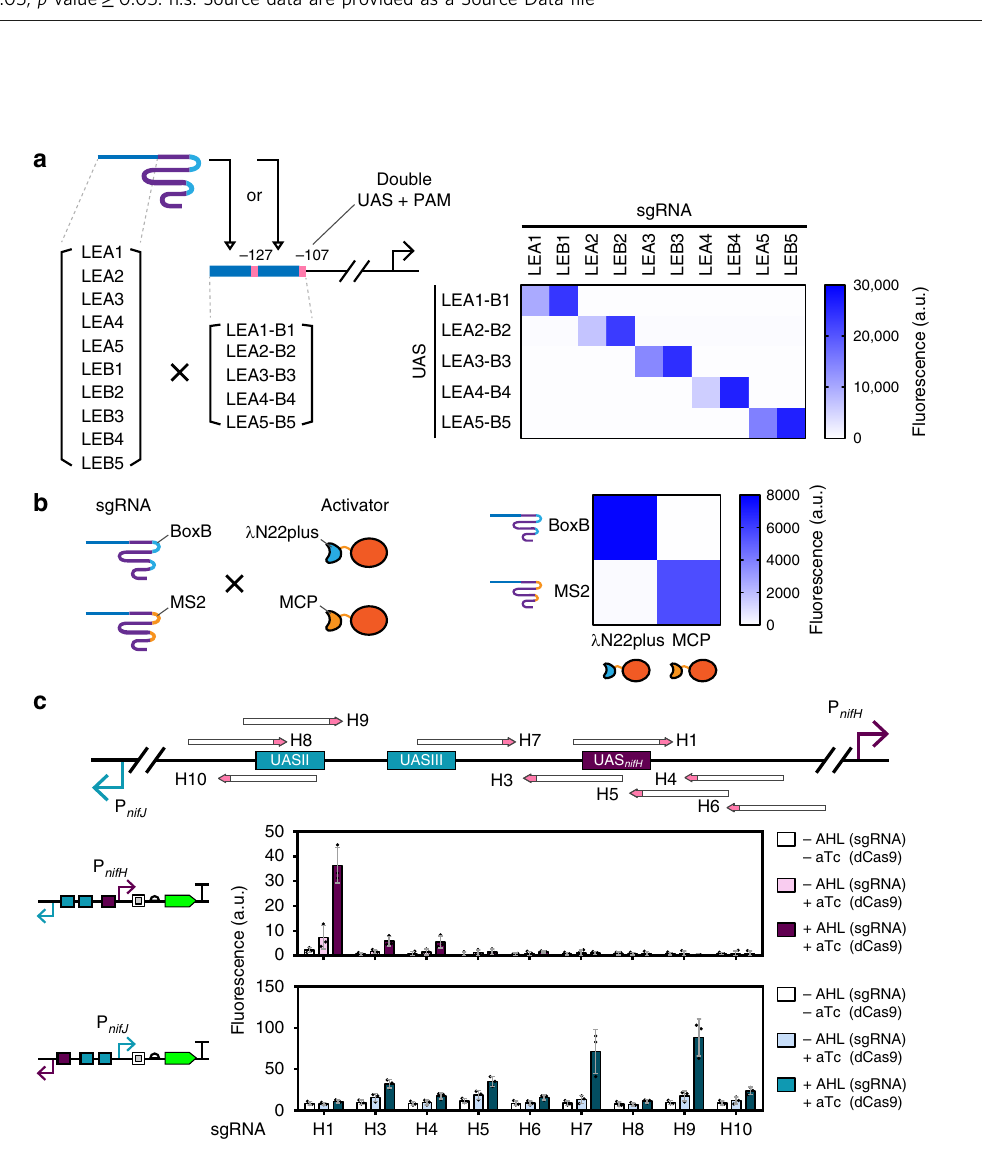
Fig. 3 Functional expansion with different σ 54 -dependent promoters and bEBPs. a Activation of P pspA , P hrpL , P nifH , P nifJ in E. coli . Inducer concentrations used: For P pspA and P hrpL activation, 1.6 µ M AHL (sgRNA), 2.5 ng mL − 1 aTc (dCas9), 0.4 m M rhamnose (activator). For P nifH and P nifJ activation, 1.6 µ M AHL (sgRNA), 2.5 ng mL − 1 aTc (dCas9), 3.2 m M rhamnose (activator). Statistical difference was determined by a two-tailed Welch ’ s t test: P pspA , p = 0.0011, t = 30.69; P hrpL , p = 0.0006, t = 38.34; P nifH (H1), p = 0.0134, t = 8.093; P nifJ (H7), p = 0.0536, t = 4.053; P nifJ (H9), p = 0.0242, t = 6.137. The data of P nifH and P nifJ are identical to those shown in Fig. 4c. b P nifH and P nifJ activation in K. oxytoca . Inducer concentrations: 2.5 ng mL − 1 aTc (dCas9), 3.2 µ M AHL (sgRNA). Statistical difference was determined by a two-tailed t test: P nifH (H1), p < 0.0001, t = 18.85; P nifJ (H7), p < 0.0001, t = 20.73; P nifJ (H9), p = 0.0165, t = 3.976. c The dynamic ranges of hybrid σ 54 -dependent promoter activation. The asterisk represents the P fl hD p2 was a predicted σ 54 -dependent promoter 60 . Activator expression was driven by the constitutive promoter BBa_J23106. Inducer concentrations used: 1.6 µ M AHL (sgRNA), 2.5 ng mL − 1 aTc (dCas9). d Orthogonal activators in E. coli TOP10. Left: Truncated NorRs were fused with a λ N22plus adaptor. Right: four activators without the HTH domain truncations were fused with a λ N22plus adaptor and tested. All engineered activators were driven by the promoter BBa_J23106. P pspA -20 was used for the reporter, which could be activated by sgRNA-LEB2. Inducer concentrations used: 0.025 µ M AHL (sgRNA), 2.5 ng mL − 1 aTc (dCas9) for ON states. Statistical difference was determined by a two-tailed t test: NorR (179-504), p < 0.0001, t = 27.54; NorR (188 – 504), p = 0.0007, t = 9.456; WtsA, p < 0.0001, t = 24.42. Error bars, s.d. ( n = 3); a.u., arbitrary units; p value summary: **** p value < 0.0001, 0.0001< *** p value < 0.001, 0.001 < ** p value < 0.01, 0.01 < * p value < 0.05, p value ≥ 0.05: n.s. Source data are provided as a Source Data fi le